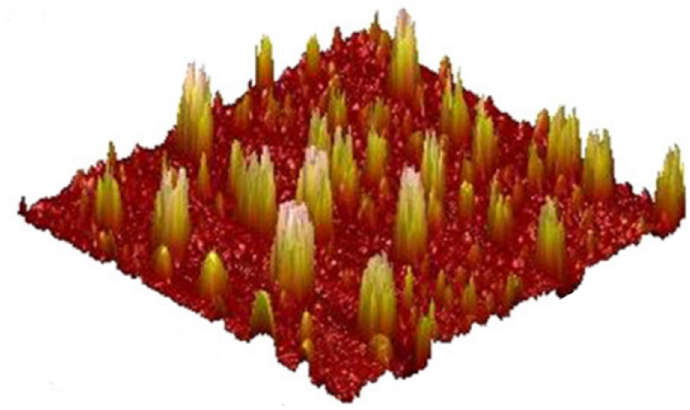
Figure 6. Atomic force microscopy (AFM) image of vertically aligned (VA)-SWCNTs / polystyrene (PS) nanocomposites (Reprinted from Macdonald, T.J.; Gibson, C.T.; Constantopoulos, K.; Shapter, J.G.; Ellis, A.V. Functionalization of Vertically Aligned Carbon Nanotubes with Polystyrene via Surface Initiated Reversible Addition Fragmentation Chain Transfer Polymerization. Appl. Surf. Sci. 2012 , 258 , 2836–2843 [16], with permission (2020) from Elsevier).